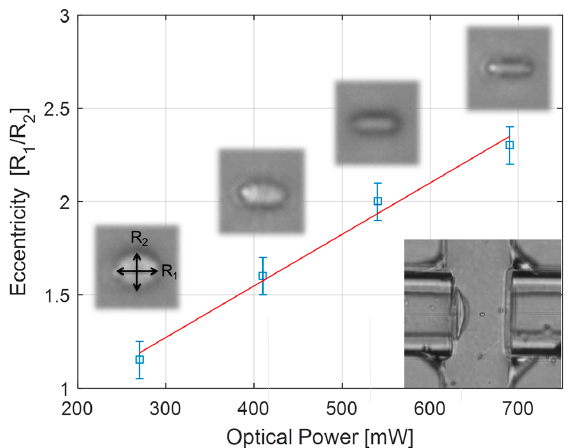
Figure 4. Stretching of a single RBC. The stretching ratios, R1/R2 of a RBC in the optical stretcher as a function of total stretching laser power. The major and minor axes of the cell were measured using the corresponding images shown as insets. Resulting values and error bars are the result of edge-detection in 30 images recorded at the same laser power. In the lower right corner, the inset shows a black and white image of a red blood cell trapped between the two SM optical fibers embedded in the microfluidic chip.